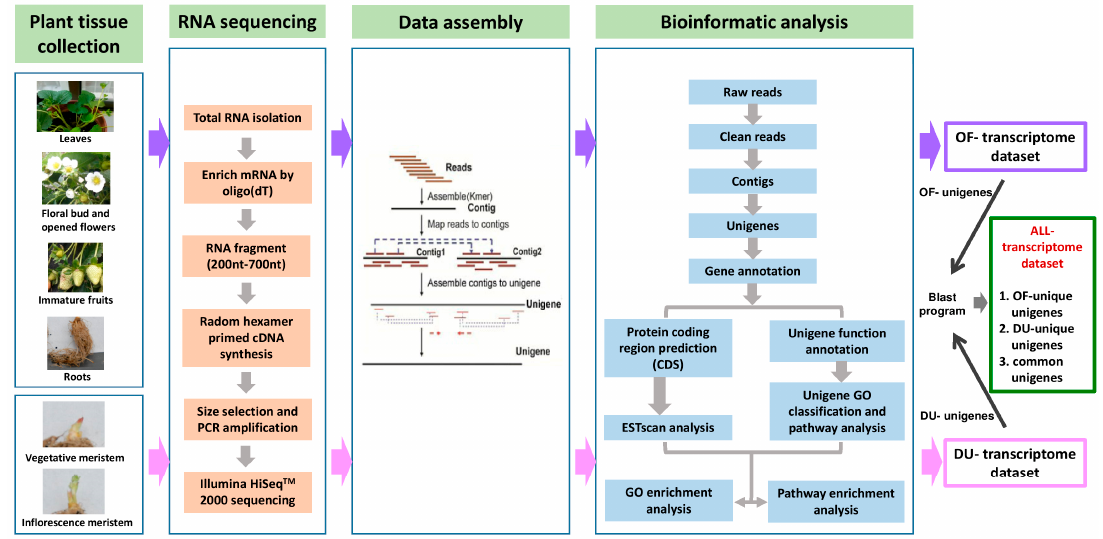
Figure 1. Flowchart of the transcriptome sequencing analysis (plant tissue collection, RNA sequencing, data assembly, and bioinformatics analysis). The total RNA was extracted from five strawberry tissues, namely leaves, floral buds, fully bloomed flowers, immature fruits, and roots. Following cDNA preparation of the extracted RNA and sequencing analysis, the retrieved data were used to set up the OF transcriptome data set. Simultaneously, the total RNA extracted from two other tissues comprising vegetative and inflorescence meristems was utilized to establish the DU transcriptome data set. Sequences of the unigenes obtained either from the OF or DU transcriptome data set were further analyzed, and common genes and unigenes unique to either OF or DU transcriptome data sets (OF- and DU-unique unigenes) were determined. To specify common unigenes, the sequence identity between the two unigenes identified separately from the data sets must be greater than 50%. In addition, its matched length must be higher than 50% of the length of both unigenes. The remaining unigenes appeared as unique to each data set. GO: gene ontology; CDS: consensus coding sequences.